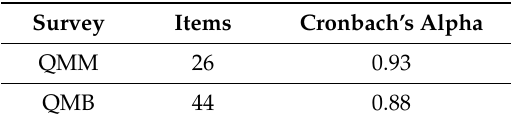
Table 4. The outcomes of the study as to the reliability of Questionnaire of Motivation in Mathematics (QMM) and Questionnaire about Mathematical Beliefs